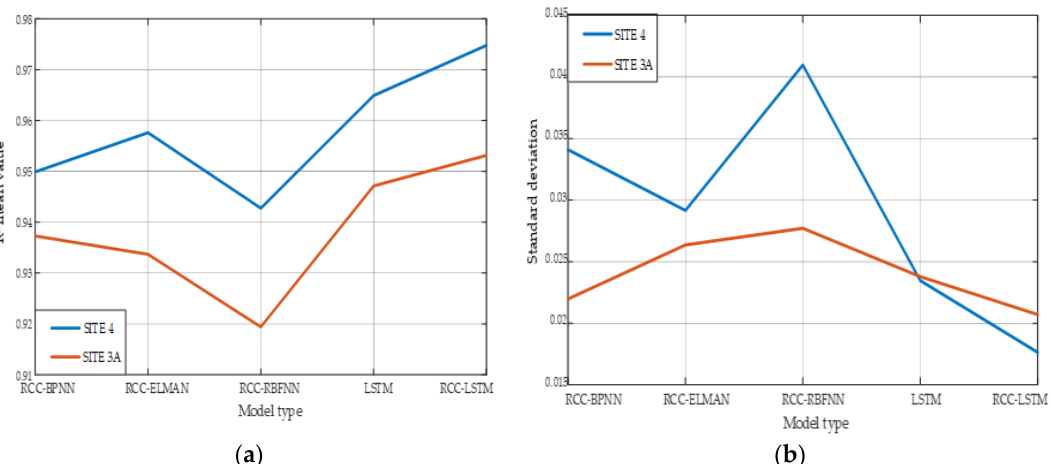
Figure 17. ( a ) The R 2 of different models in two PV systems; ( b ) The standard deviation of R 2 in two PV systems.